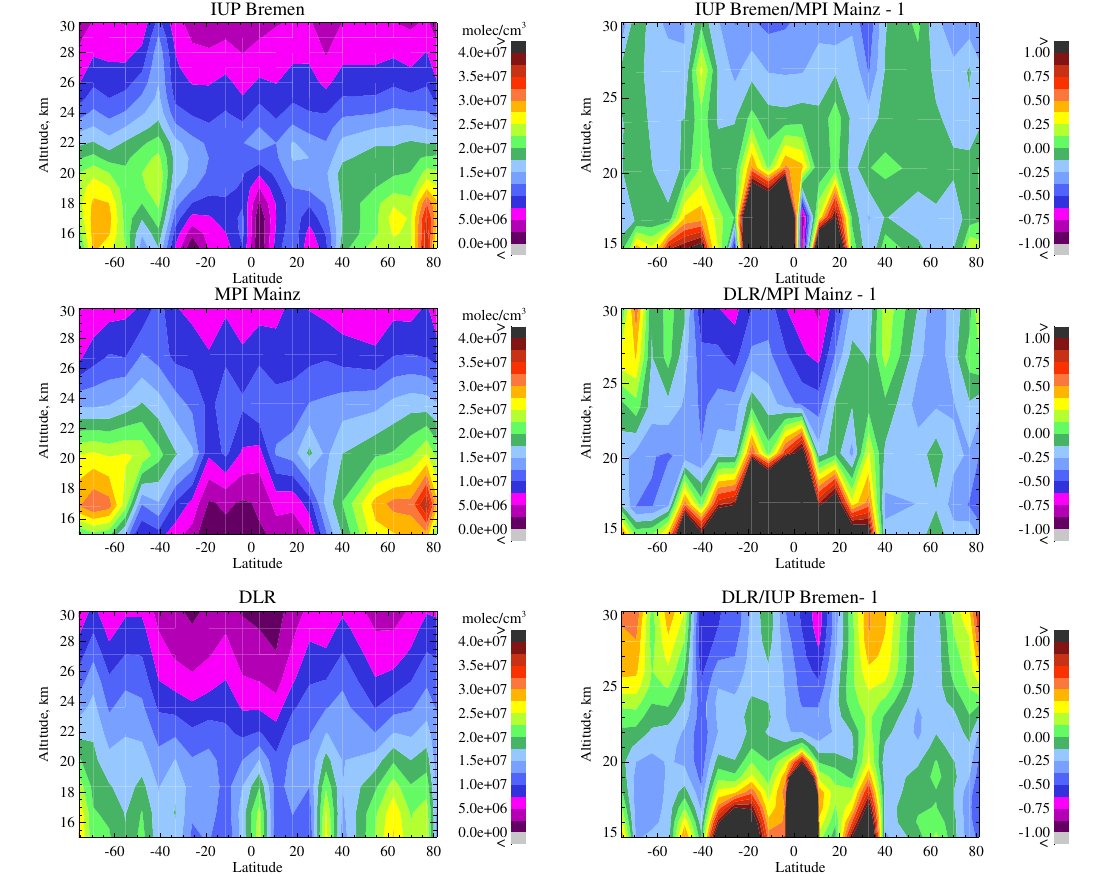
Fig. 19. Intercomparison of three SCIAMACHY BrO products for a selected orbit (Orbit 10811, 25 March 2004). Left panels: BrO vertical distributions retrieved form SCIAMACHY limb measurements with different algorithms. Right panels: relative differences in the retrieved BrO